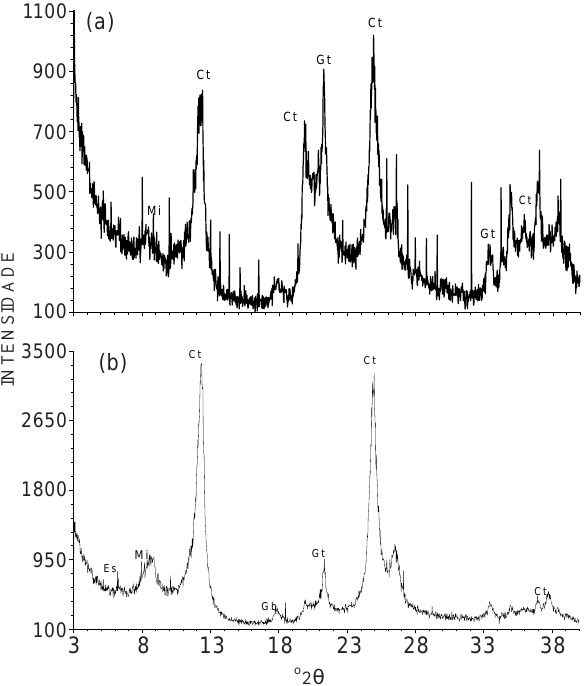
Figura 4. Difratogramas de raios-X da fração argi- la orientada do horizonte B do PVAe do Gru- po Araxá (amostra 13), mostrando a mineralo- gia antes (a) e depois do estudo de cinética (1.382 h de contato com ácido cítrico 0,1 mol L -1 ) (b): Es - esmectita, Ct - caulinita, Gb - gibbsita, Gt - goethita e Mi - mica.